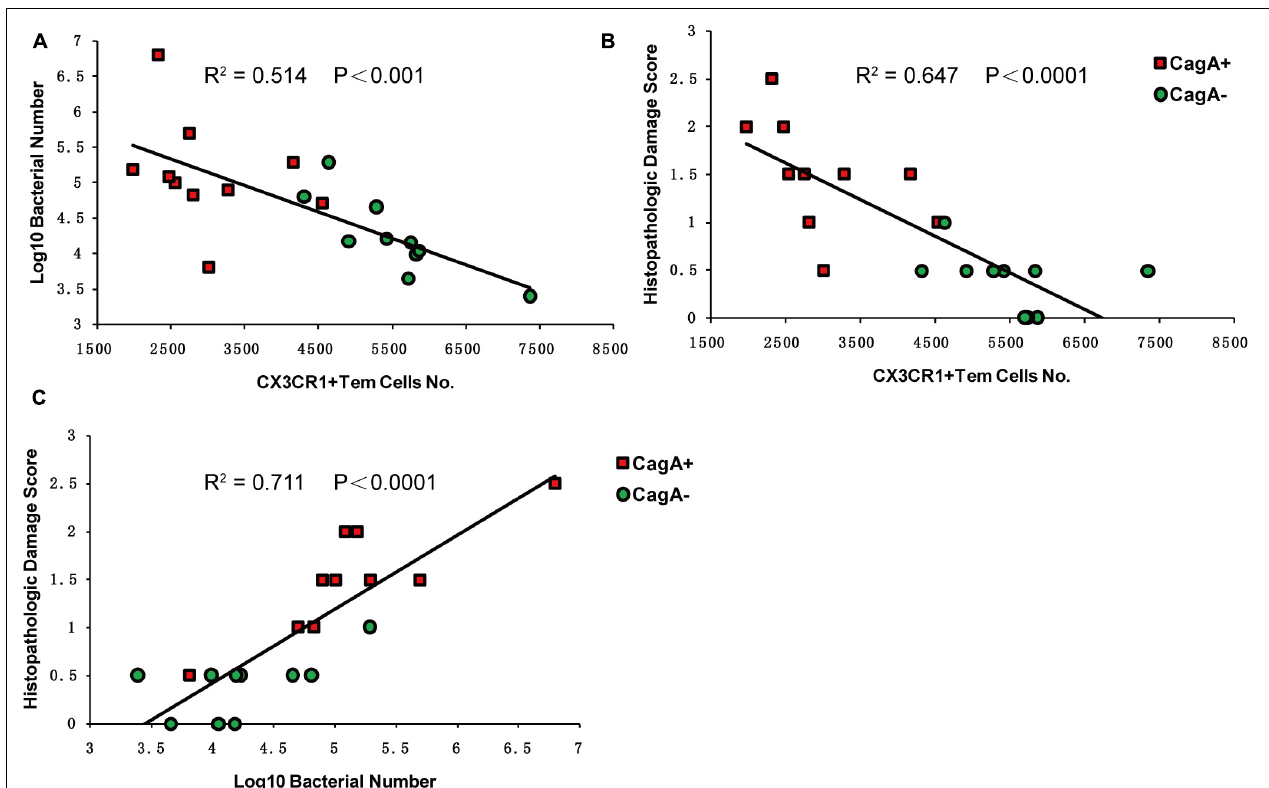
FIGURE 5 | Pearson correlation analysis of CX3CR1 + CD4 + Tem cell number, histopathologic damage score, and H. pylori colonization level in mice stomachs. Four weeks post H. pylori infection, CX3CR1 + CD4 + Tem (CD3 + CD4 + CX3CR1 + CD44 + CD69 − CCR7 − ) cell population, histopathologic damage score, and H. pylori colonization in the mice stomachs were measured. (A) Pearson correlation analysis of H. pylori colonization and CX3CR1 + CD4 + Tem population. (B) Pearson correlation analysis of the histopathologic damage score and CX3CR1 + CD4 + Tem population. (C) Pearson correlation analysis of the histopathologic damage score and H. pylori colonization. N = 20, the values of R 2 and P are shown. Results are representative of three separate